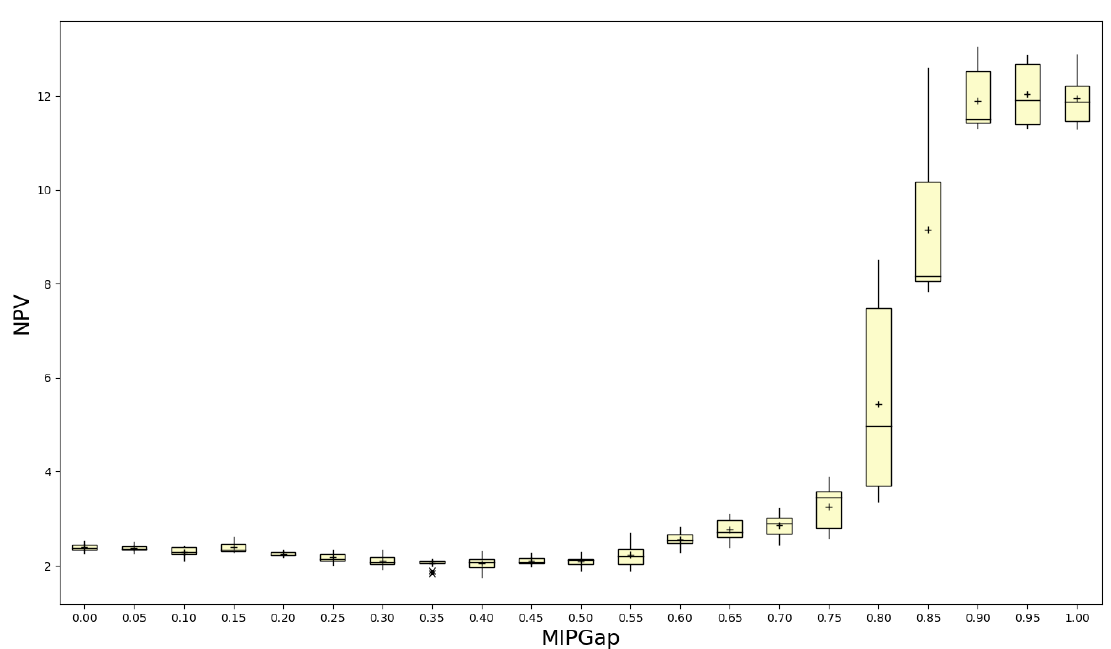
Figure 2. Boxplot comparison of instance 1 results with different alpha values.